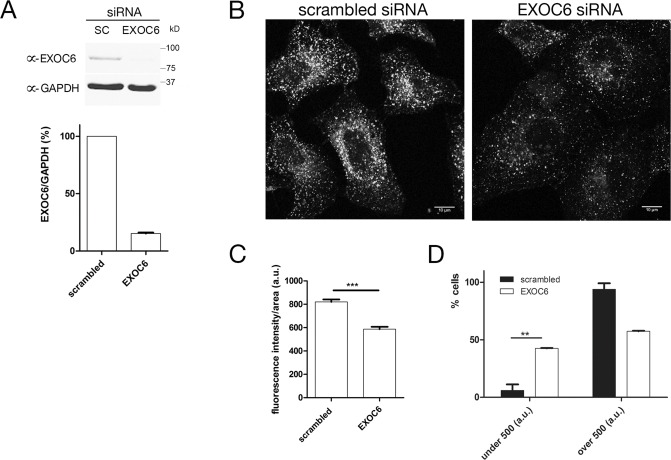
The exocyst functions in endocytosis in human cells.(A) Immunoblots of lysates prepared from HeLa cells treated with either scrambled or EXOC6 siRNA smart pools as shown in panel B, probed with anti-EXOC6 or anti-GAPDH as indicated. Knockdown levels of EXOC6 were quantified from 3 experiments of this type and are presented as a ratio of EXOC6/GAPDH signals. (B) HeLa cells depicting transferrin uptake. Cells treated with either scrambled or EXOC6 siRNA were imaged after the uptake of labelled transferrin (10 min). Representative fields of cells from 3 independent replicates. (C) The fluorescence intensity of >100 cells for each condition was determined using ImageJ and the data compared using an unpaired t test. *** P value < 0.0001. (D) The image intensity of >100 cells of each condition were binned into two groups, those with a signal intensity >500 arbitrary units, and those <500. Knockdown of EXOC6 was found to significantly increase the fraction of cells with a signal intensity <500 (** P value <0.01), consistent with a decrease in transferrin endocytosis.